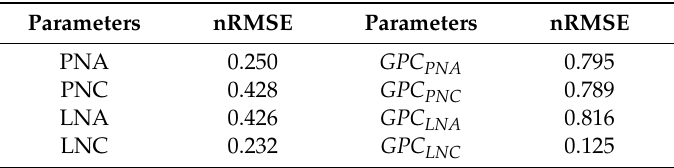
Table 12. nRMSE of four nitrogen nutrition parameters and wheat grain protein inversion results based on the 2017–2018